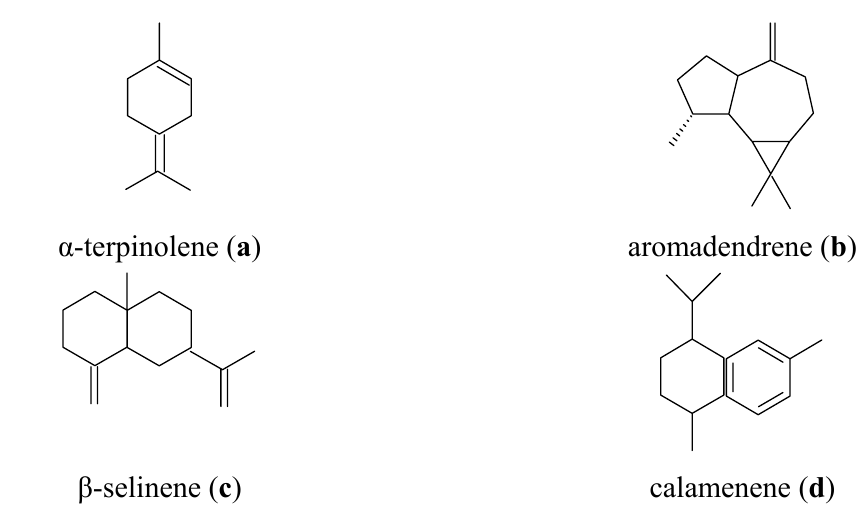
Figure 3. Structures of compounds which have good correlation for anticancer ( a–c ) and antimalarial ( d )